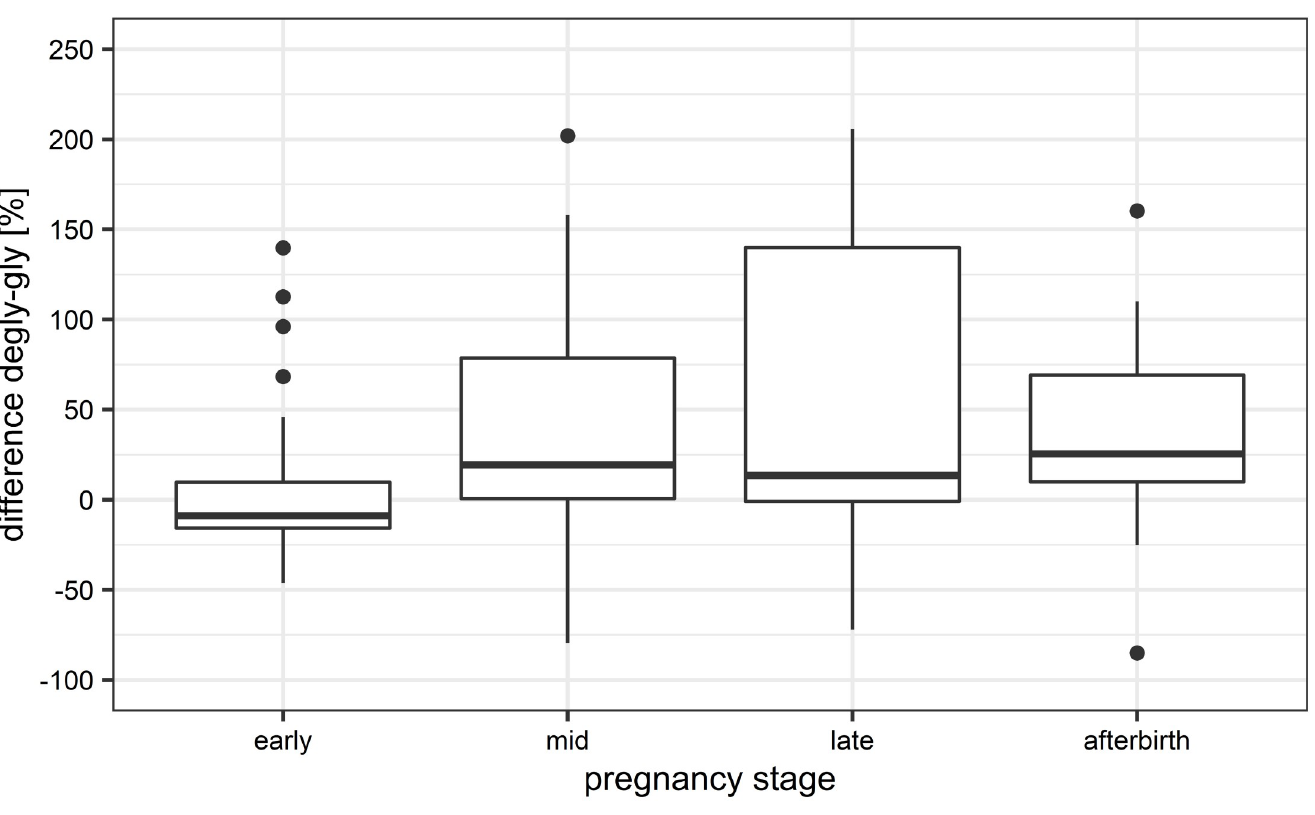
Fig 5. Box-and-whisker plot visualization of the percentage change of Total Area Fragment values from peptides between deglycosylated and glycosylated samples in the course of pregnancy and post-partum.